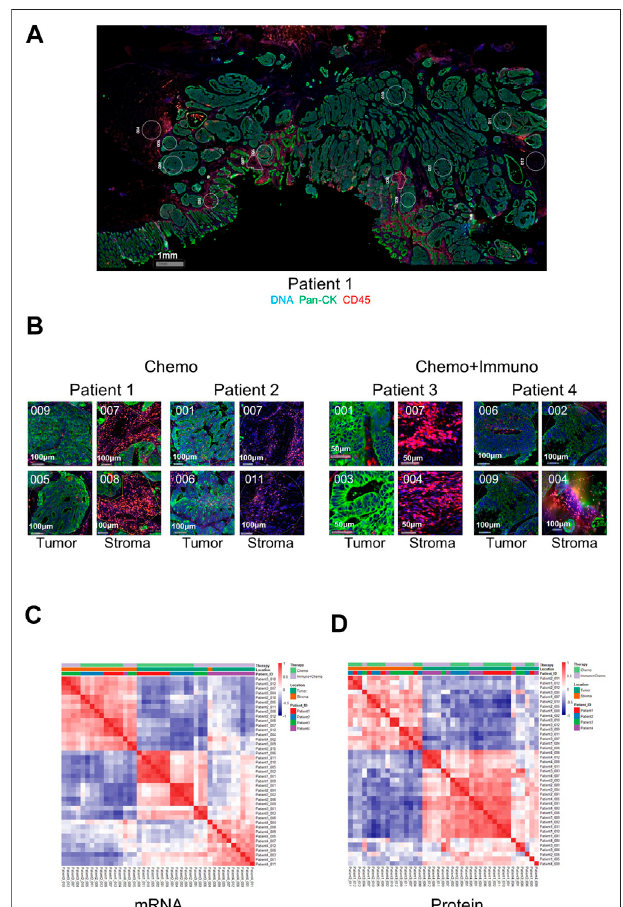
FIGURE 1 | Representative full scan and regions of interest (ROIs) from patients and ROI-based correlation matrices on 84-plex RNA and 40-plex proteins. (A) Representative full-scan image for patient 1. (B) Representative ROI images for all patients. For every patient, 12 ROIs were drawn, and four representative ROIs (2 tumors and 2 stroma) are shown with tricolor fl uorescence labeling (blue: SYTO13, green: Pan-cytokeratin, Pan-CK, red: CD45) at 20x magni fi cation (patients 1 and 2: chemotherapy only, patients 3 and 4: chemotherapy + immunotherapy). For correlation matrices, ROIs are grouped based on treatment options, ROI location (tumor or stroma), and patient IDs. (C) mRNA-based expression correlation matrix shows separate stromaandtumorROIclusters,andseparatetherapy-dependentROIclusters in tumor regions. QC-failed and normal epithelium ROIs were excluded. (D) Protein-based expression correlation matrix shows separate stroma and tumor ROI clusters. QC-failed and normal epithelium ROIs were